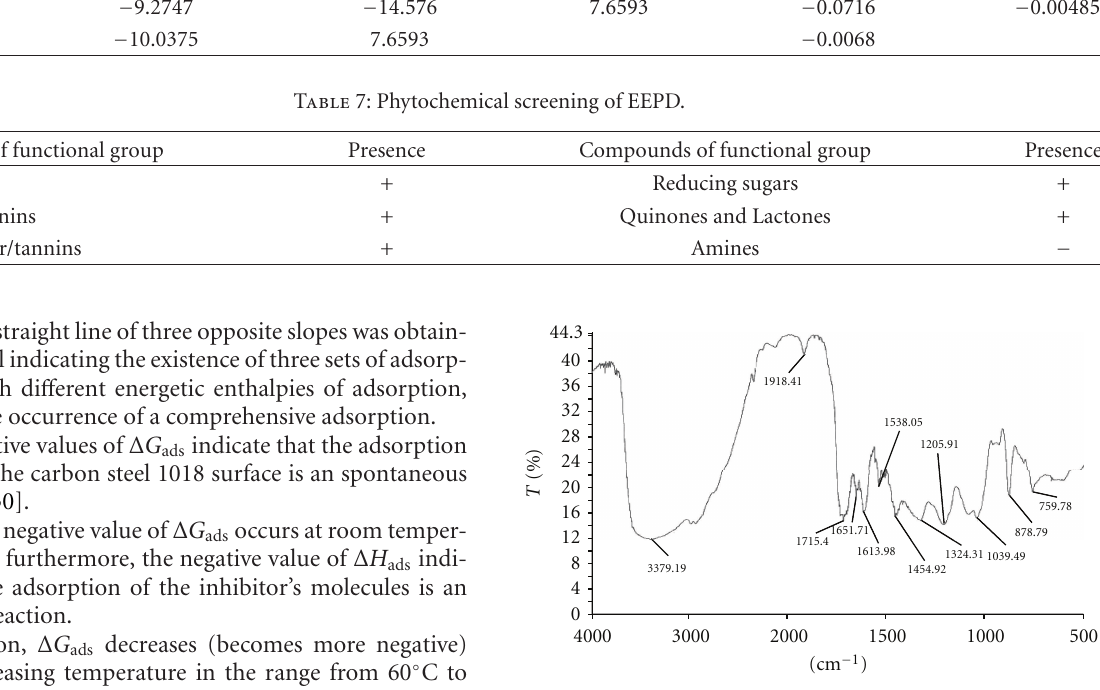
Figure 4: IR spectra of ethanol extract of Pachycormus